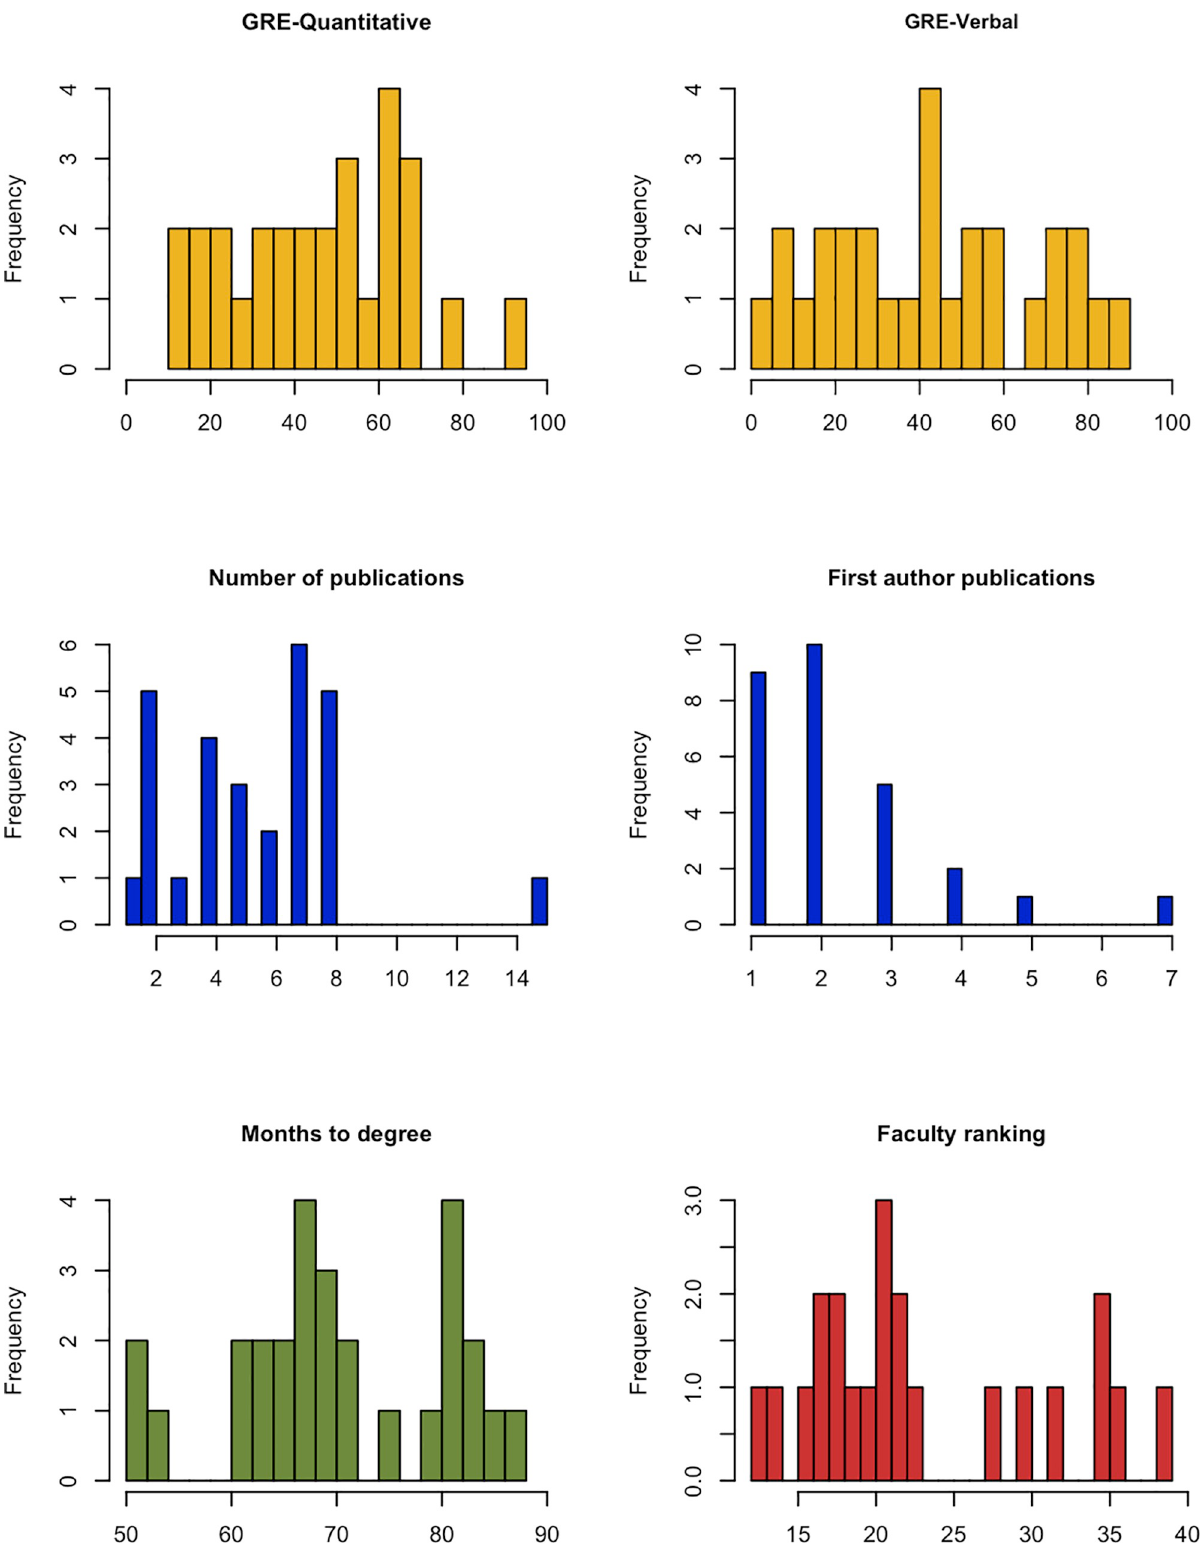
Fig 2. Histograms of outcomes data. Frequencies of GRE scores (Q% and V%), number of publications, months to degree, and faculty ranking are shown as indicated. https://doi.org/10.1371/journal.pone.0201634.g002 PLOS ONE | https://doi.org/10.1371/journal.pone.0201634 March 21,